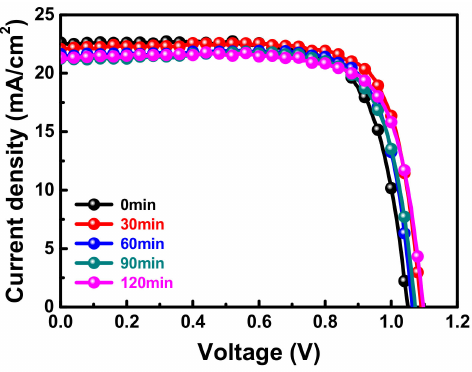
Figure 3. J–V curves of PSCs prepared with various delayed annealing times. Table 2. The photovoltaic characteristics of PSCs with perovskite films prepared with various delayed annealing times. Time